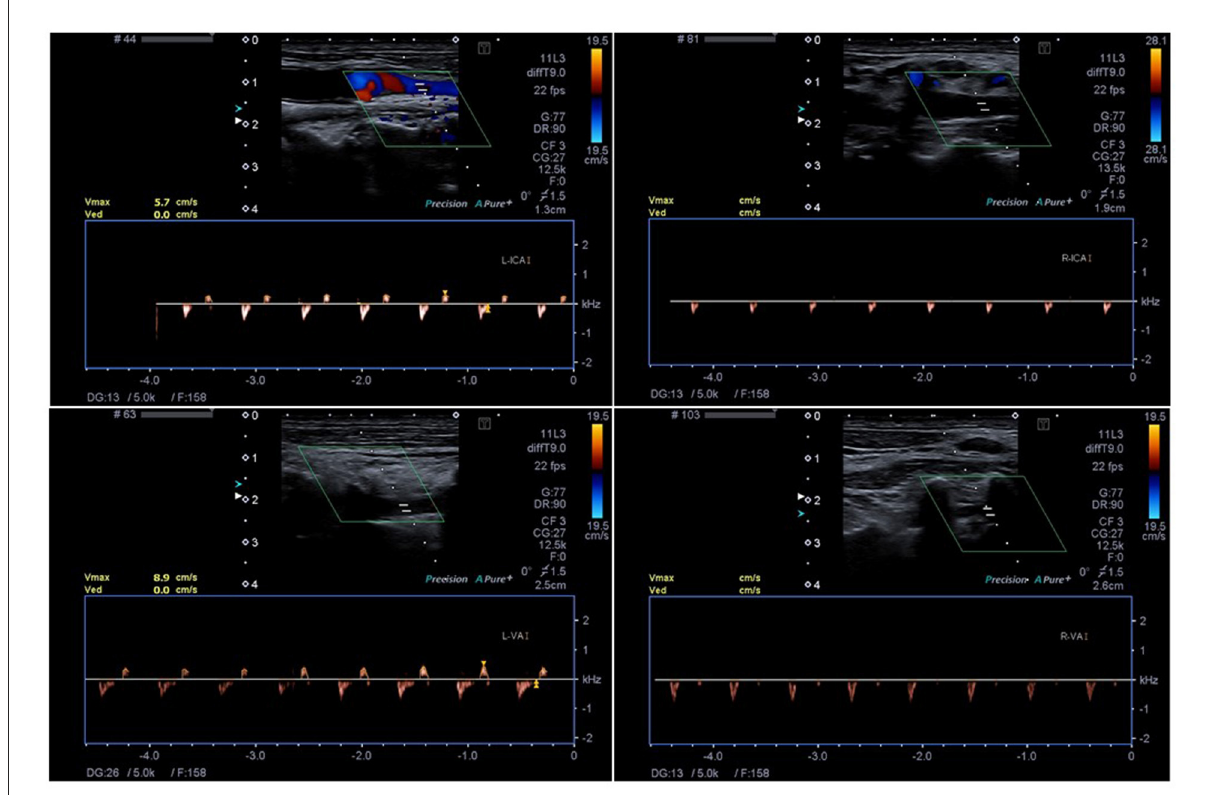
FIGURE1 The Technique of ECCD with detection of small systolic spikes in the right ICA (R-ICA) and VA (R-VA) and biphasic flow in the left ICA (L-ICA) and VA (L-VA). The insonation depth is 1.9cm (R-ICA), 2.6cm (R-VA), 1.3cm (L-ICA) and 2.5cm (L-VA), respectively.